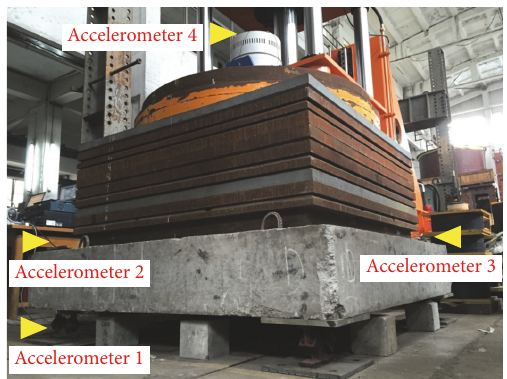
Figure 16: Test scheme of impulse vibration test on scaled models.